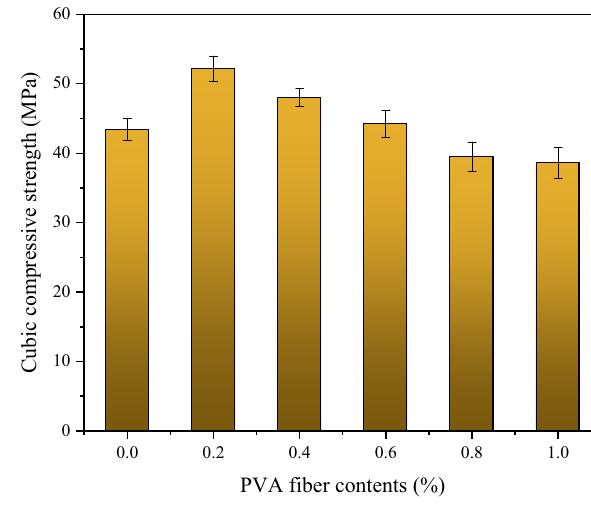
Figure 7: Cubic compressive strength versus PVA fi ber